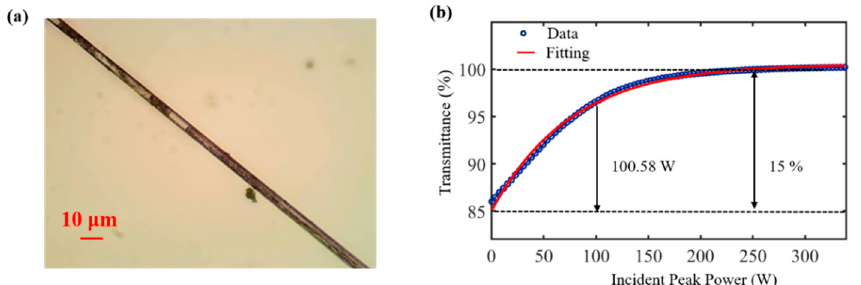
Figure 3. ( a ) WSe 2 -SA: WSe 2 -modified tapered fiber; ( b ) saturation absorption characteristics.